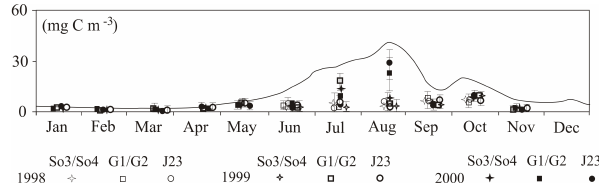
Fig. 9. Observed Acartia spp. biomass for the Gdansk Gulf com- pared to simulated population (solid line) – based surface biomass concentrations 0–20m (mgCm − 3 ); full circles – data from J23 sta- tion, full squares – data from G1 and G2 stations, full stars – data from So3 and So4 stations from 2000; half-open circles – data from J23 station, half-open squares – data from G1 and G2 stations, half- open stars – data from So3 and So4 stations from 1999; open circles – data from J23 station, open squares – data from G1 and G2 sta- tions, open stars – data from So3 and So4 stations from